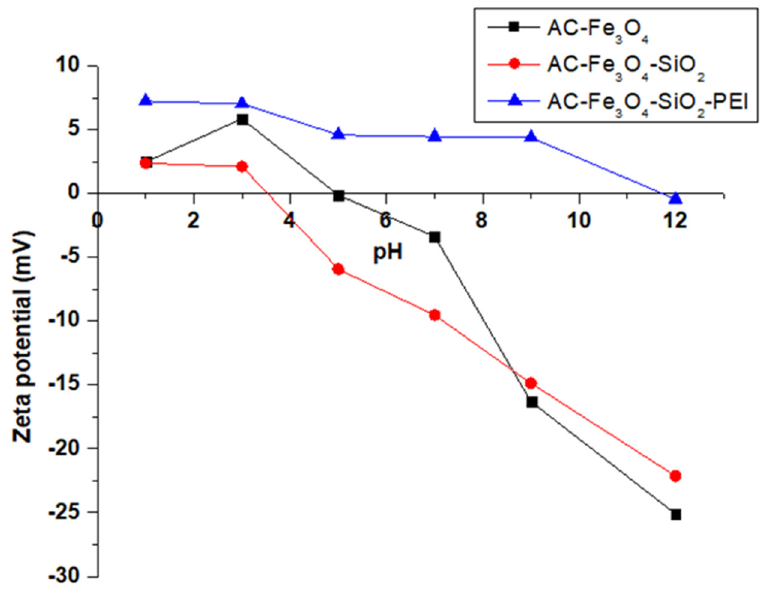
Figure 7. Zeta potential of AC-Fe 3 O 4 , AC-Fe 3 O 4 -SiO 2 and AC-Fe 3 O 4 -SiO 2